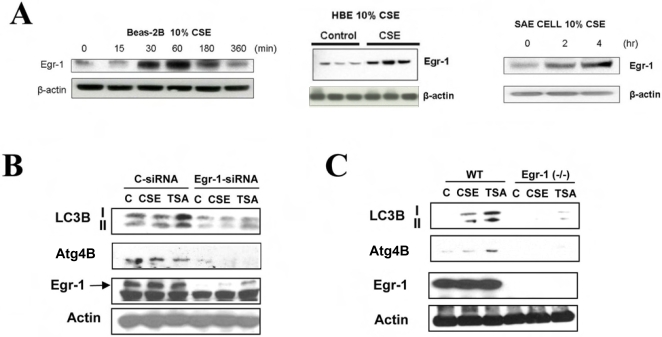
Expression of LC3B requires Egr-1.(A) Beas-2B, HBE, or SAE cells were treated with 10% CSE, for the times indicated and assayed for the expression of Egr-1 by Western immunoblot analysis. Images are representative of 3 independent experiments. (B) Beas-2B cells were pretreated with control siRNA (C-siRNA), or Egr-1 siRNA for 48 h, followed by the treatment with 20% CSE or 100 nM TSA for an additional 24 h. Cells were then harvested for Western blot analysis. β-Actin served as the standard. (C) Lung fibroblasts derived from wild type C57BL/6 or Egr-1−/− mice were treated with 20% CSE or 100 nM TSA for 24 h. Lysates were analyzed by Western immunoblotting for LC3, or Egr-1. β-Actin served as the standard.